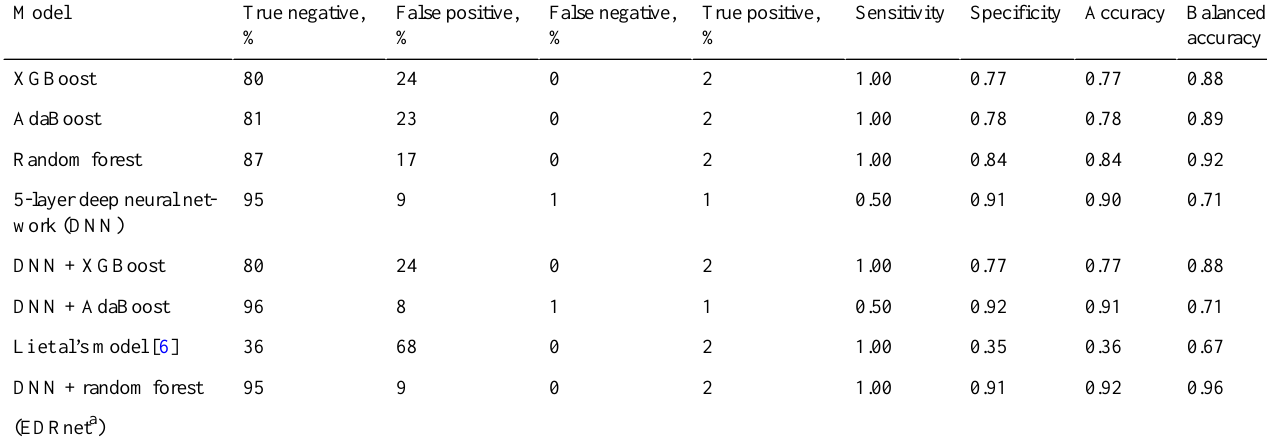
Table 6. Comparison of the performance of various